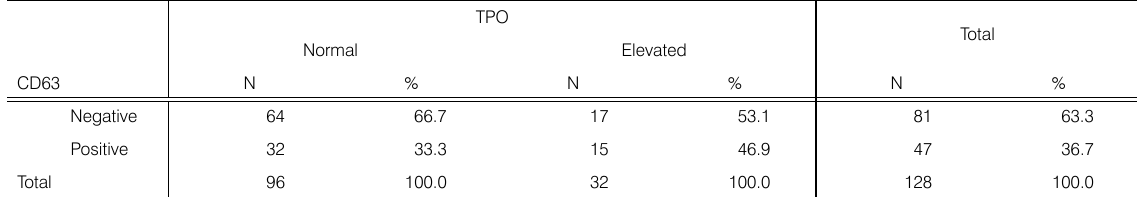
Table 3. Relation of TPO and CD63 expression results